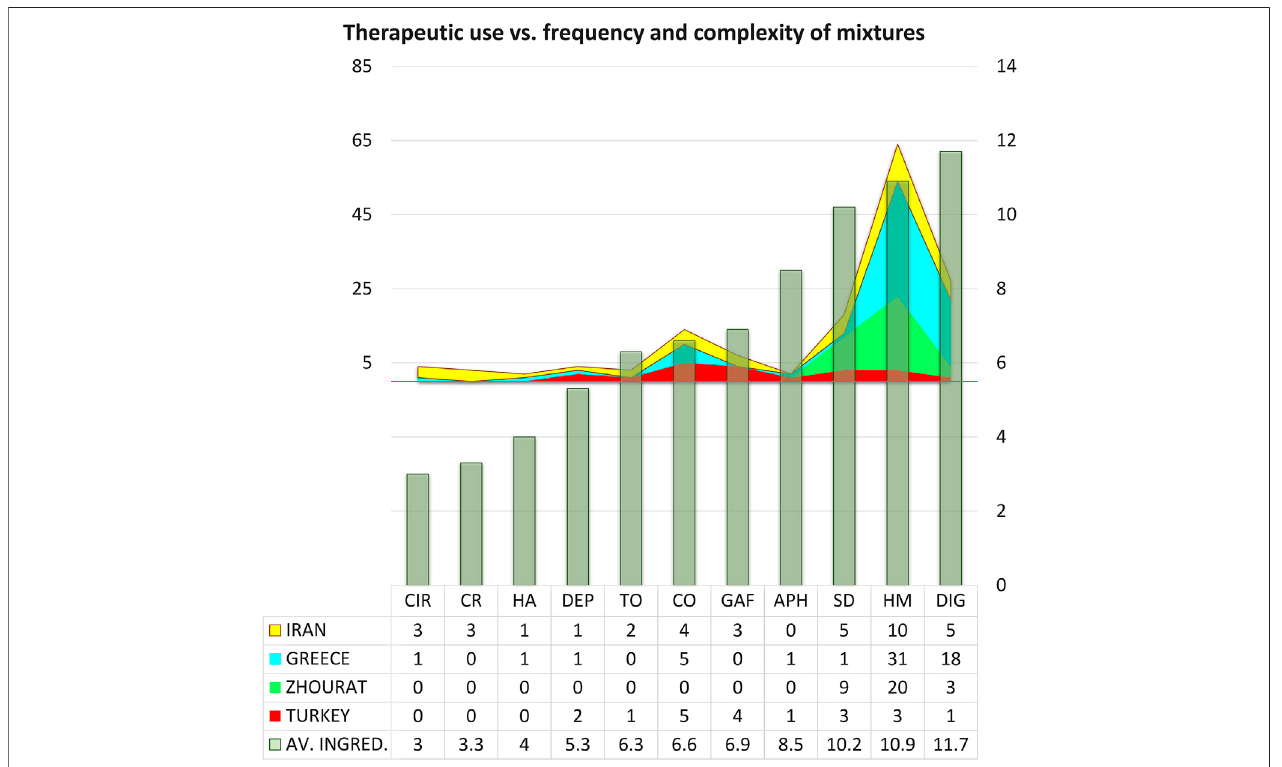
FIGURE 3 | Main categories of traditional uses of the analyzed herbal mixtures. Axes: X (cid:1) Categories of therapeutic use. Abbreviations: CIR, circulatory; CR, anticancer; HA, headache; DEP, depurative; TO, tonic; CO, treatment of common cold; GAF, has a good aroma and fl avor; APH, aphrodisiac; SD, sedative; HM, good for health, herbalteas, consumed to preserve health and prevent diseases; DIG, digestive, good for stomach. Y (right, 0 – 12) Foreground: Complexity ofmixtures used for each speci fi c category. Abbreviations: Data: AV. INGRED, average number of ingredients. Y (left, 0 – 65) Background : Number of samples analyzed from each country which belong to each category of